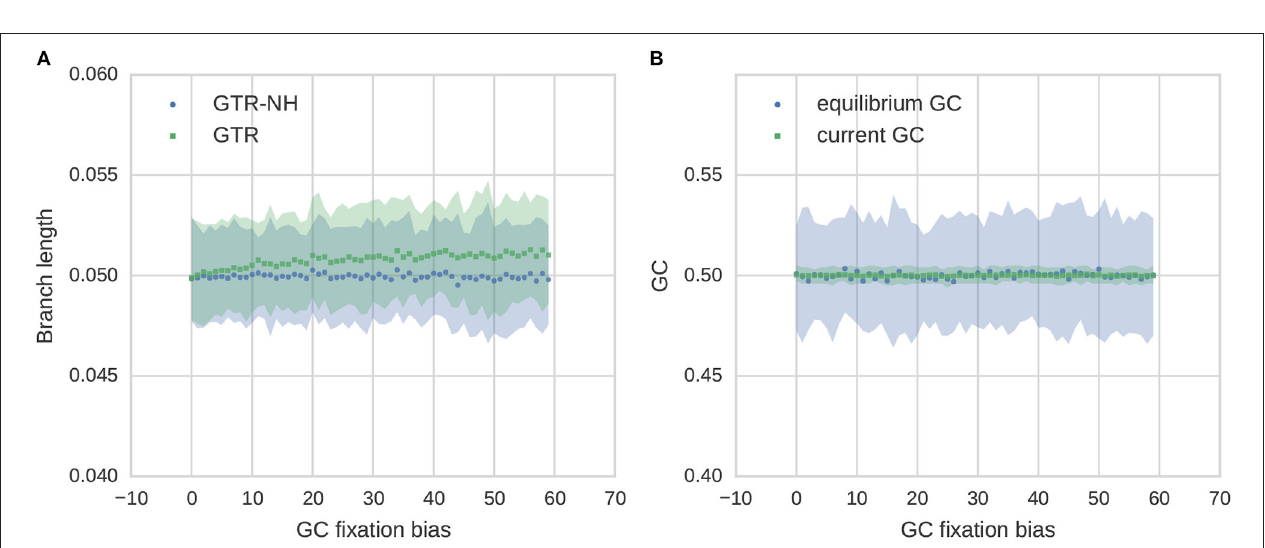
FIGURE 3 | Features of GC content evolution in the non-focal terminal branch simulated under stationary GC when the focal branch is simulated with different levels of GC fixation bias and their 95% CIs. Terminal branch length under consideration is set to 0.05 in the simulations. (A) Estimated branch lengths under varying strength of GC fixation bias in the focal branch for stationary and non-stationary models. (B) GC content evolution, shown is equilibrium GC (GC*) and GC content at the tip of the branch (current